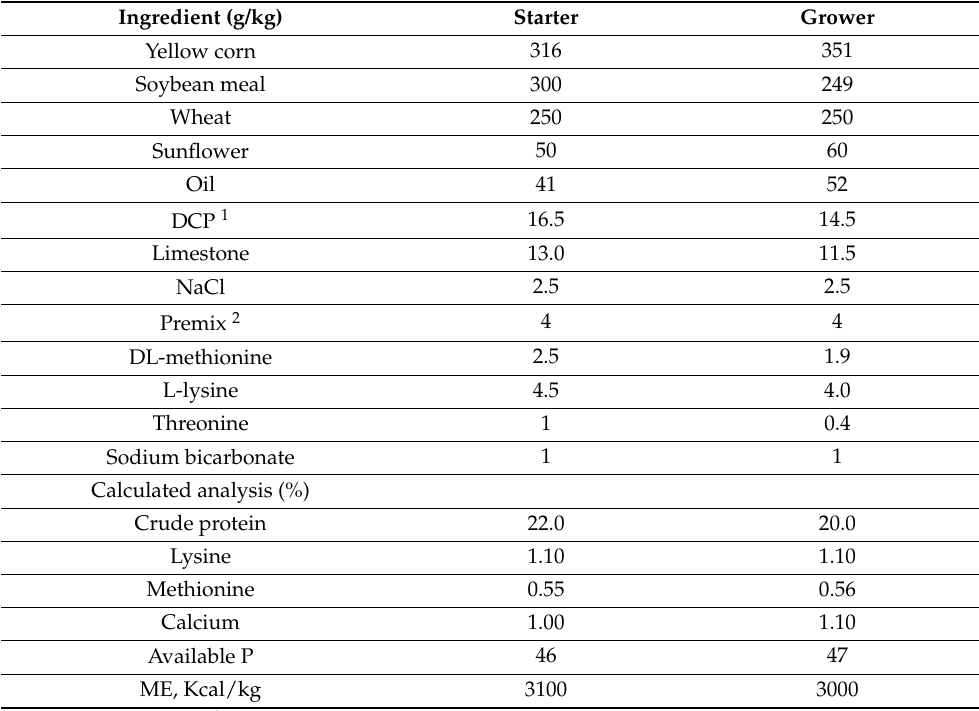
Table 1. Composition of the basal diets fed to broilers in the feeding trial, g/kg. Ingredient (g/kg) Starter Grower Yellow